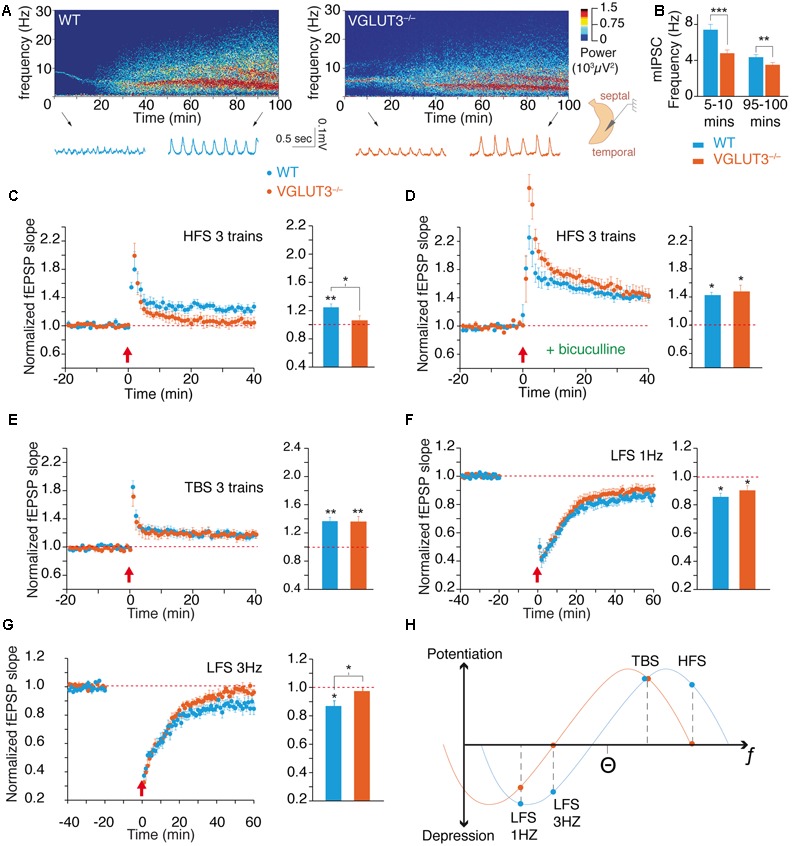
VGLUT3 regulates the theta oscillations and the metaplasticity of hippocampus network. (A) Examples of theta oscillation recordings in the CA1 region of an intact hippocampus preparation in vitro. The upper panels represent power spectrograms over time (power is coded in color) in the WT and VGLUT3-/- (n = 12–14) mice. Oscillations are shown under the power spectrograms at the beginning (5–10 min) and end (95–100 min) of the recordings. (B) Mean frequency of theta oscillations at the beginning and end of the recordings. Theta frequency decreased over time and was significantly slower in the VGLUT3-/- mice than in the WT mice (n = 14–15). (C) LTP at Schaffer collateral-CA1 (Sch-CA1) synapses induced by HFS (3 × 100 Hz, red arrow) in WT and VGLUT3-/- (n = 9–10) mice. Histogram showing the mean value of the fEPSP slope 40 min after LTP induction. Significant LTP was induced in the WT mice, whereas no significant LTP was induced in the VGLUT3-/- mice (n = 9–10). (D) LTP at Sch-CA1 synapses induced by HFS (red arrow) after GABA-A receptor blockade with bicuculline (5 μM). Histogram showing the mean value of the fEPSP slope 40 min after LTP induction. A LTP of similar amplitude was induced in the WT and VGLUT3-/- mice (n = 6). (E) LTP at Sch-CA1 synapses induced by TBS (red arrow). Histogram showing the mean value of the fEPSP slope 40 min after LTP induction. A LTP of similar amplitude was induced in the WT and VGLUT3-/- mice (n = 8–9). (F) LTD at Sch-CA1 synapses induced by LFS (1 Hz, 15 min, red arrow). Histogram showing the mean value of the fEPSP slope 60 min after LTD induction. A LTD of similar amplitude was induced in the WT and VGLUT3-/- mice (n = 6–9). (G) LTD at Sch-CA1 synapses induced by LFS (3 Hz, 15 min., red arrow) in WT and VGLUT3-/- mice. Histogram showing the mean value of the fEPSP slope 60 min after LTD induction. Significant LTD was induced in the WT mice (n = 7), whereas no significant LTD was induced in the VGLUT3-/- mice (n = 7). (H) Schematic representation of the plot of plasticity amplitude as a function of the strength of the stimulation protocol in the presence or absence of VGLUT3. The curve obtained with VGLUT3-/- mice is shifted toward lower frequencies. This indicates that VGLUT3-/- mice are still capable of bidirectional plasticity in the hippocampus. However, the loss of VGLUT3 strongly increases local GABA transmission and hence slows down the entire network and shifts metaplasticity toward the left. ∗P < 0.05, ∗∗P < 0.01, ∗∗∗P < 0.001.